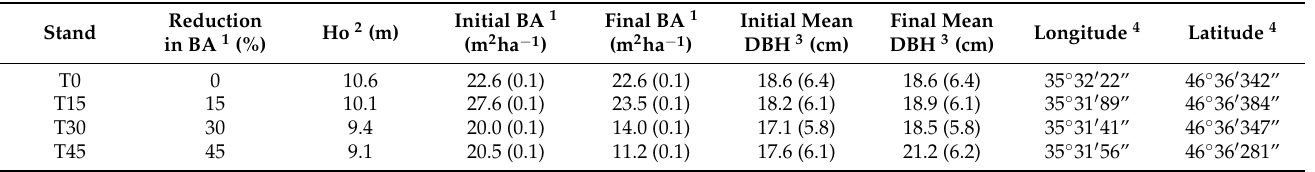
with bigger diameter; 3 quadratic mean diameter at breast height. Mean value and standard devia ‐